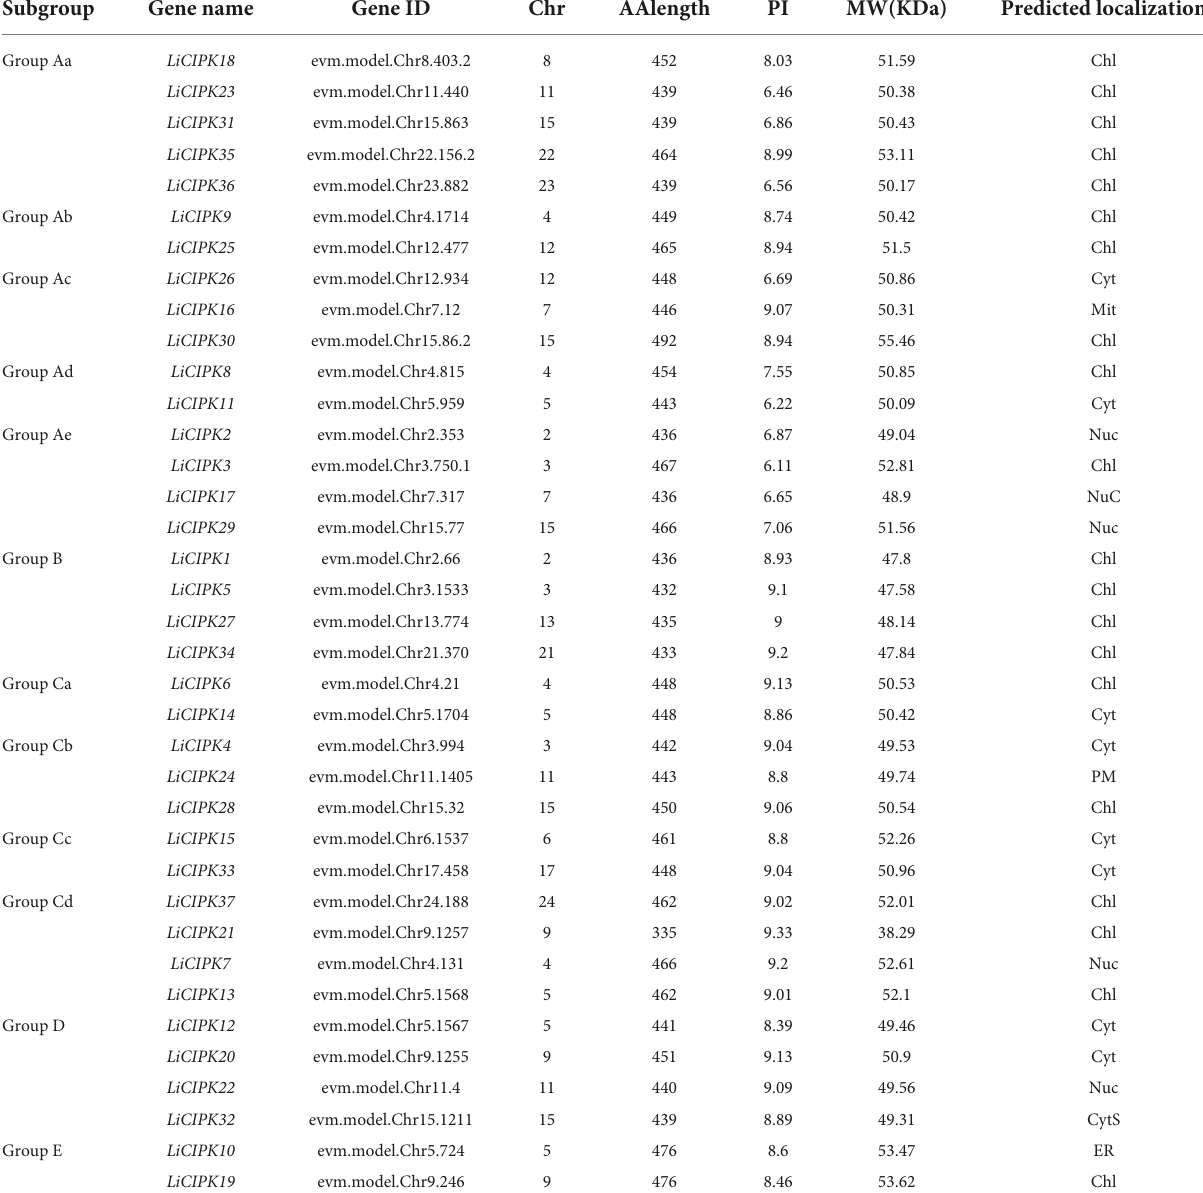
TABLE 1 Characteristic of